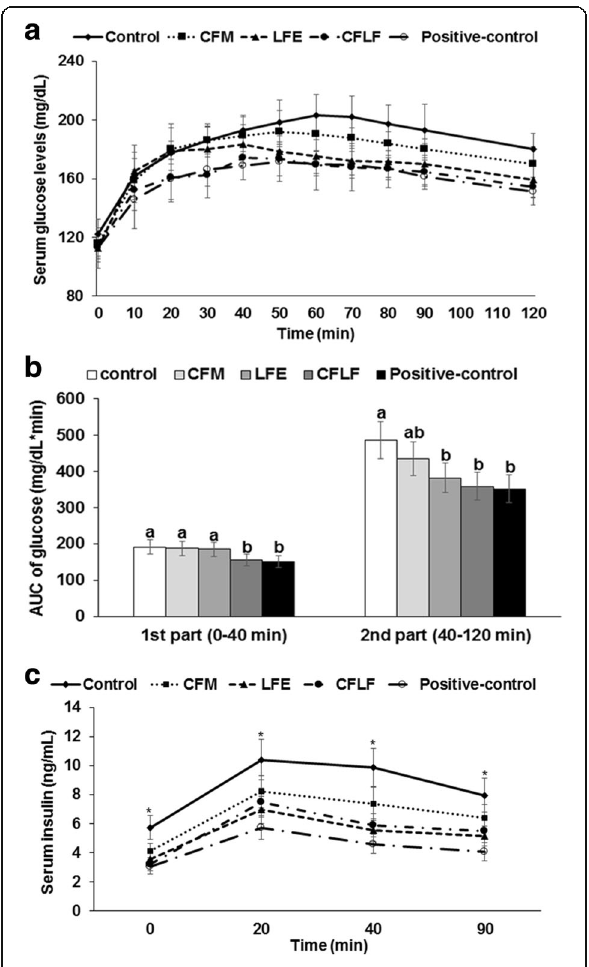
Fig. 2 Serum glucose concentrations and area under the curve of glucose and insulin during oral glucose tolerance test (OGTT). Control, OVX rats fed a high-fat diet (HFD) with 1% dextrin; CFM, OVX rats fed an HFD with 1% lyophilized cauliflower mushroom; LFE, OVX rats fed an HFD with 0.1% L . fermentum plus 1% dextrin; CFLF, OVX rats fed an HFD with 1% CFM plus 0.1% L . fermentum ; positive-control, OVX rats fed an HFD with 1% dextrin plus 30 μ g/kg body weight 17 β -estradiol. Changes of serum glucose concentration were measured during OGTT ( a ) and the average of the area under the curve (AUC) of glucose during the first part (0 – 40 min) and second part (40 – 120 min) of OGTT ( b ) was given. The changes of serum insulin levels were shown ( c ). Each dot and bar represents the mean ± SD ( n = 12). Asterisk indicates significantly different among the treatments of OVX rats at p < 0.05. Different letters represent a significant difference in Tukey test at p < 0.05